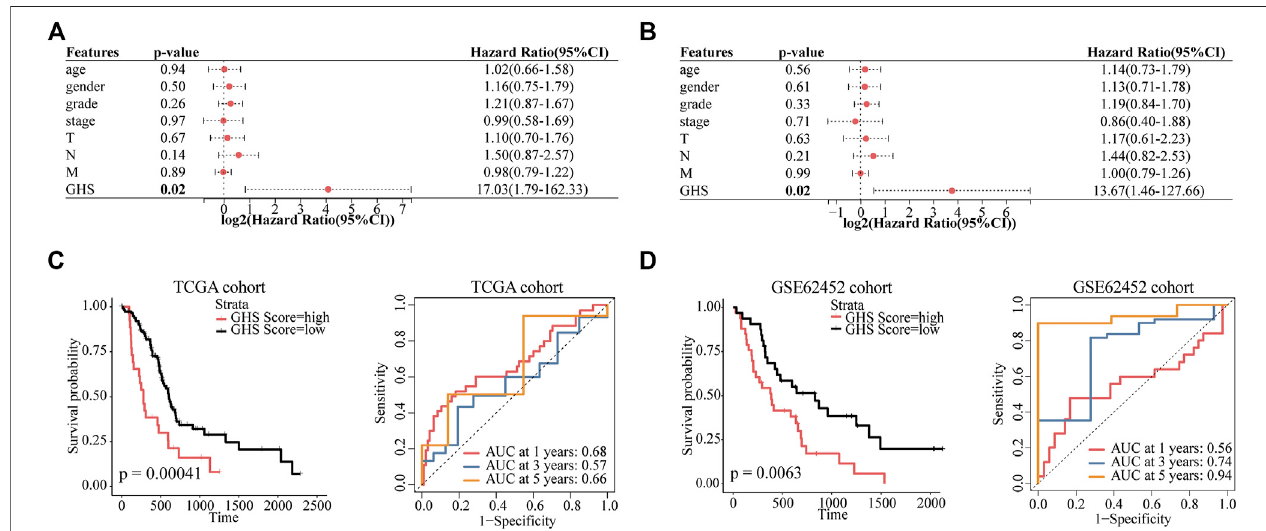
FIGURE 6 | GHS score is an independent prognostic factor for PDAC patients. (A) Forest plot of GHS related to overall survival in univariate Cox regression analysis. (B) ForestplotofGHSrelatedtooverallsurvivalinmultivariateCoxregressionanalysis. (C) TCGAcohortoverallsurvival(OS)curvesforhighandlowGHSscore groups (left) (time-dependent ROC curves for predicted 1-/3-/5-year overall survival by GHS score (right). (D) GSE62452 cohort overall survival (OS) curves for high and low GHS score groups (left) (time-dependent ROC curves for predicted 1-/3-/5-year overall survival by GHS score (right).